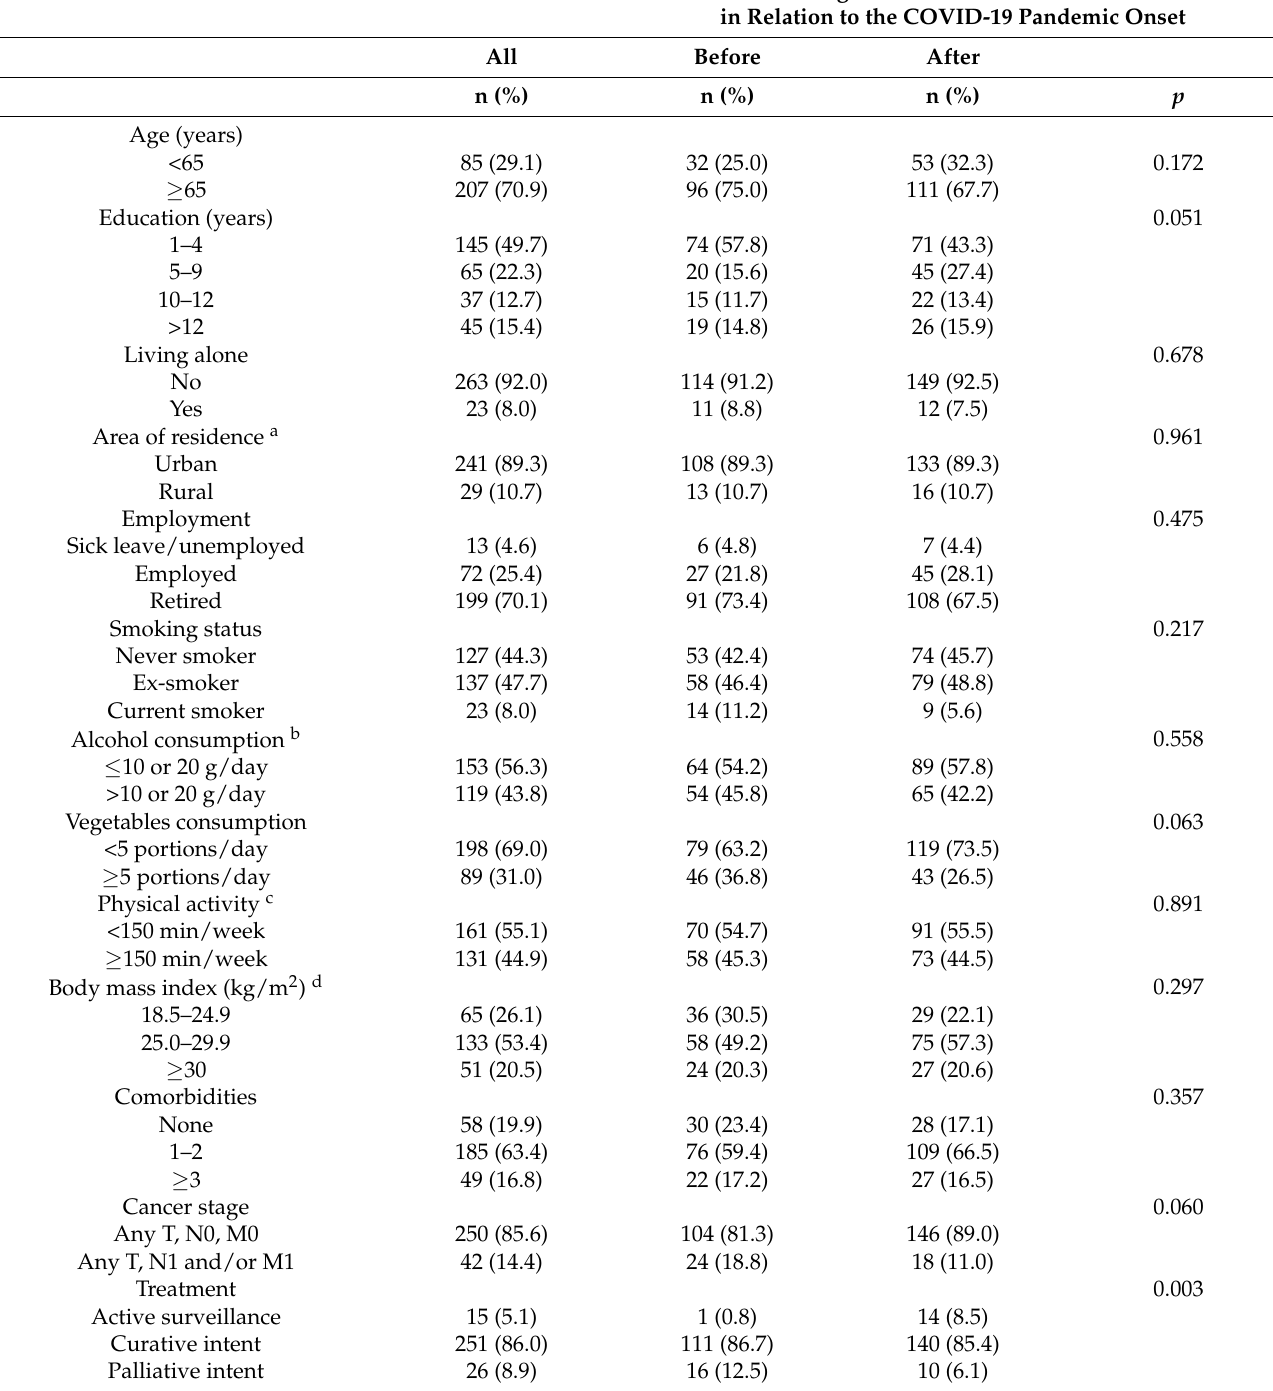
Table 1. Sociodemographic characteristics, lifestyles, and clinical information of the participants. Timing of the One-Year